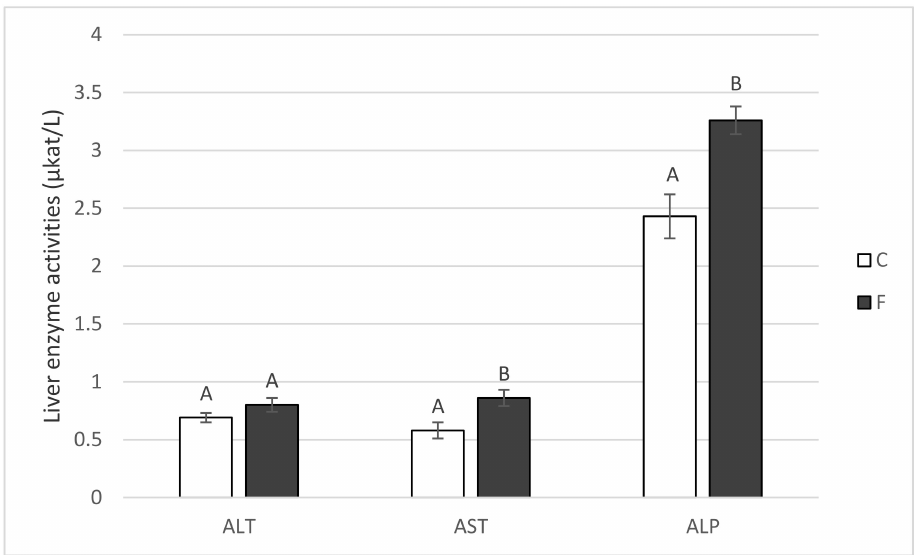
Figure 4. Activities of the liver enzymes alanine transaminase (ALT), aspartate transaminase (AST) and alkaline phosphatase (ALP) of pigs fed for four weeks on either the control standard feed mixture (C) or feed mixture enriched with 8% fish oil (F). Means with di ff erent letters within the given parameter di ff er at p < 0.05 (Mann–Whitney U test; n =